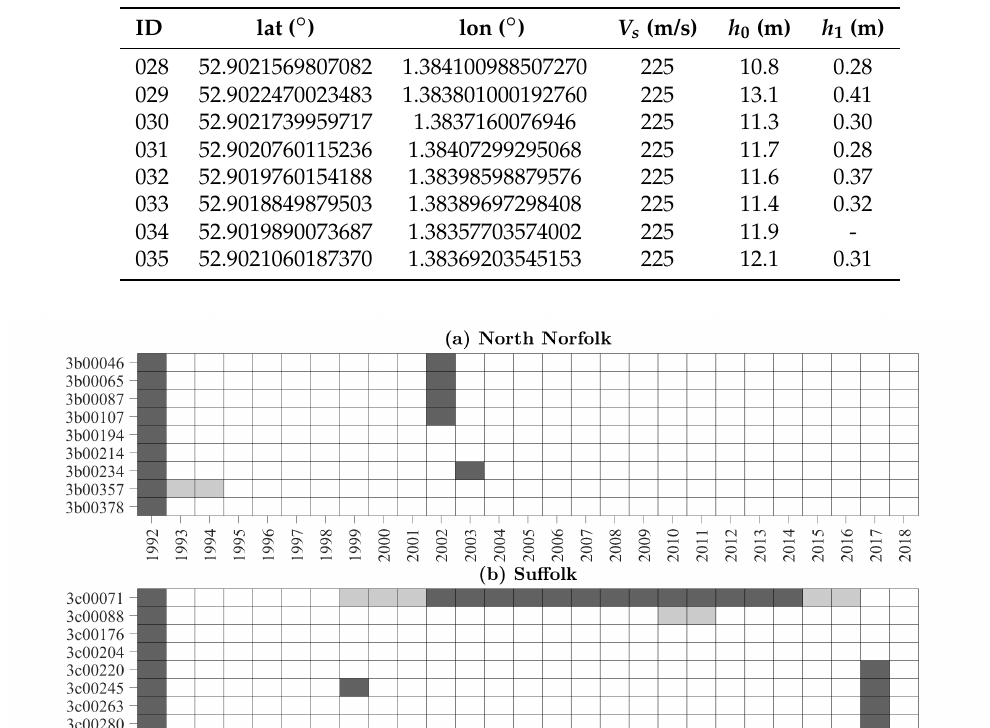
Table A2. Results from the passive seismic survey method: ID locations shown in Figure 4, lat-lon in WGS 84—WGS84—World Geodetic System 1984, shear wave velocity V s (considered as the average for typical values in sandy beaches), thickness of Crag Group layer h 0 , and thickness of beach sediment layer h 1 for each location point. The missing value corresponds to an unclear f 1 peak in the analysis.